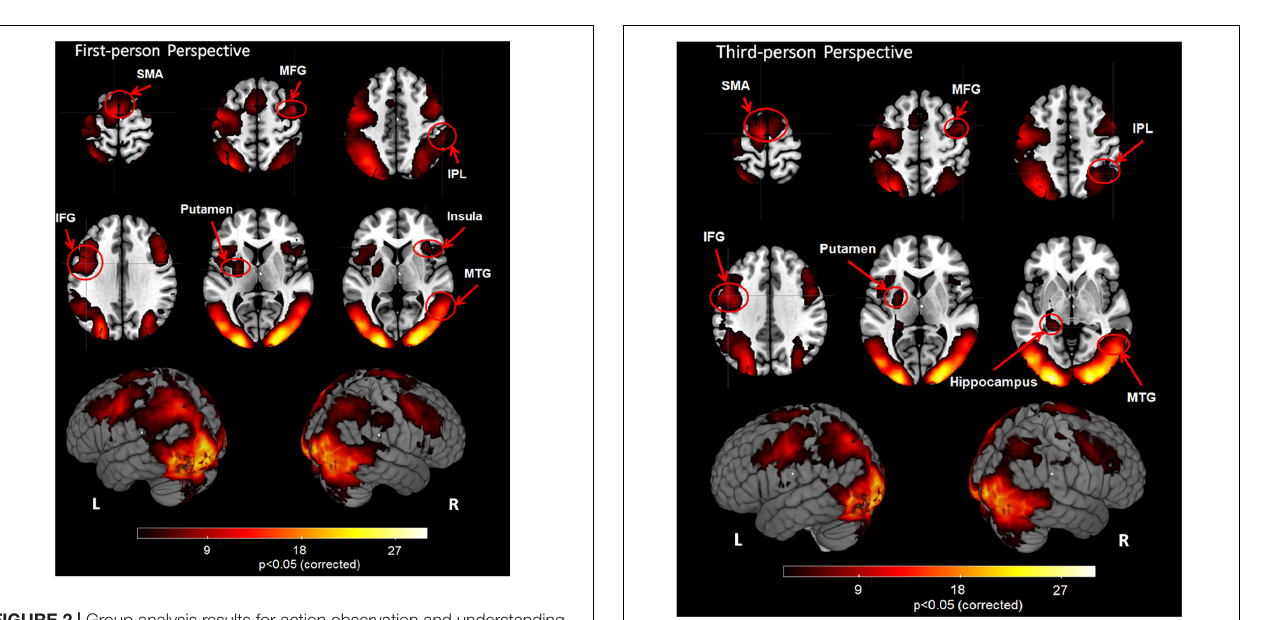
FIGURE 3 | Group analysis results for action observation and understanding from the third-person perspective with a Z-statistic threshold of 2.3 and corrected cluster P < 0.05. SMA: supplementary motor area; MFG, middle frontal gyrus; IPL, inferior parietal lobule; IFG, inferior frontal gyrus; MTG, middle temporal gyrus; L, left hemisphere; R, right